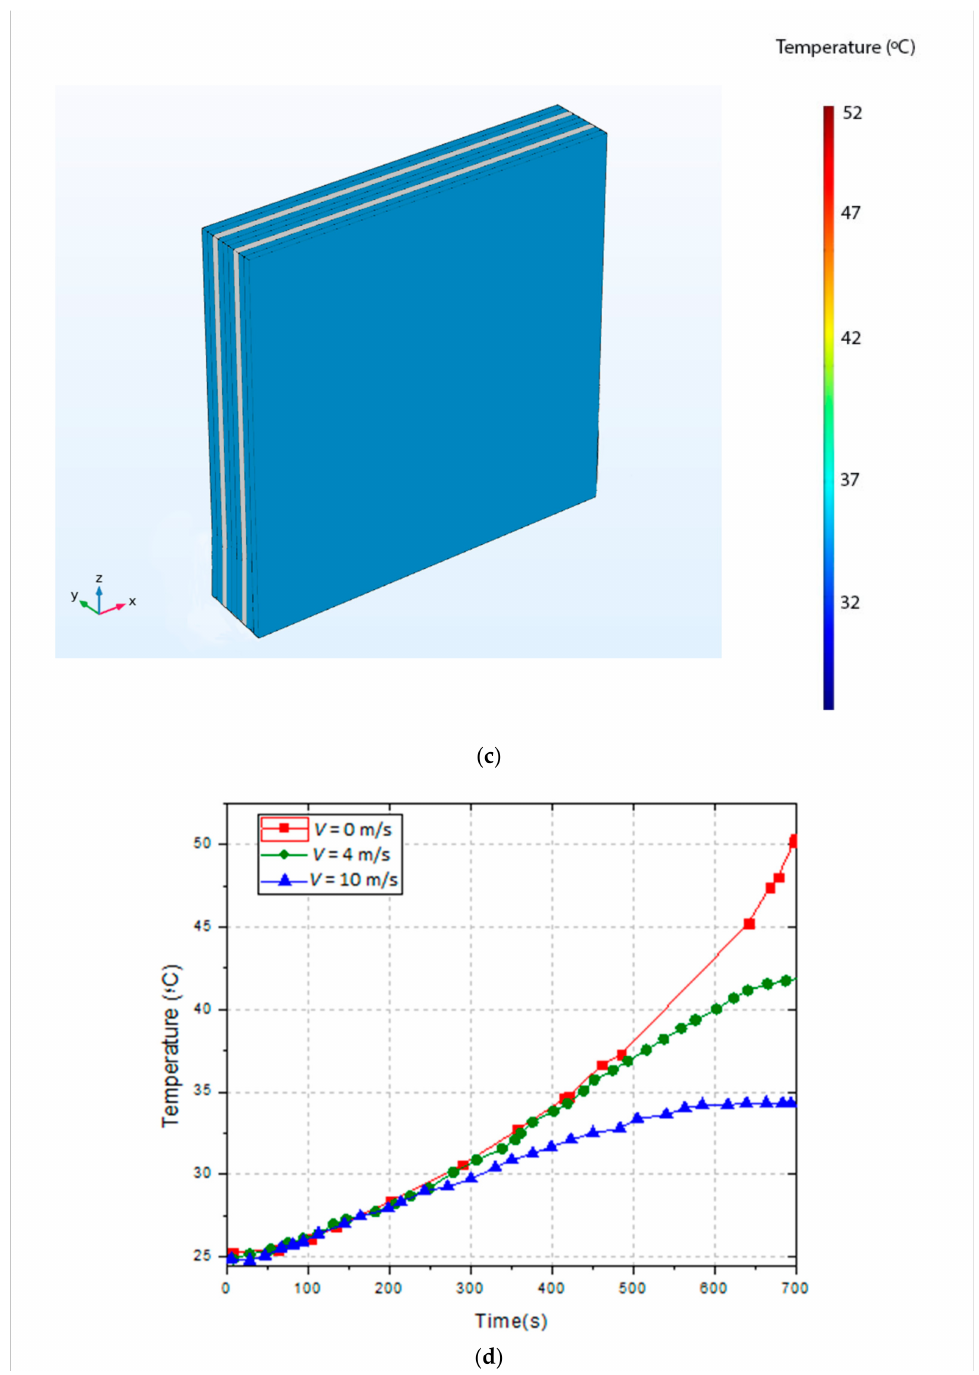
Figure 7. Comparison among the temperature variation inside the Li-ion battery stack under di ff erent airflow rates: ( a ) Temperature distribution inside the LiFePO 4 battery stack without air flow cooling; ( b ) Temperature distribution inside the LiFePO 4 battery stack at air flow of V = 4 m / s; ( c ) Temperature distribution inside the LiFePO 4 battery stack at Air flow of V = 10 m / s; ( d ) Temperature curve under di ff erent air flow